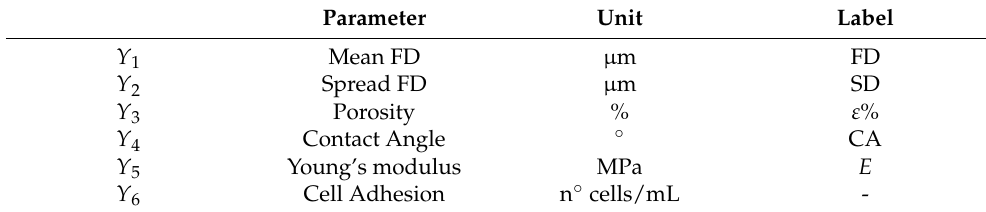
Table 3. Outputs ( Ys )—selected scaffold properties/functions examined in this investigation.